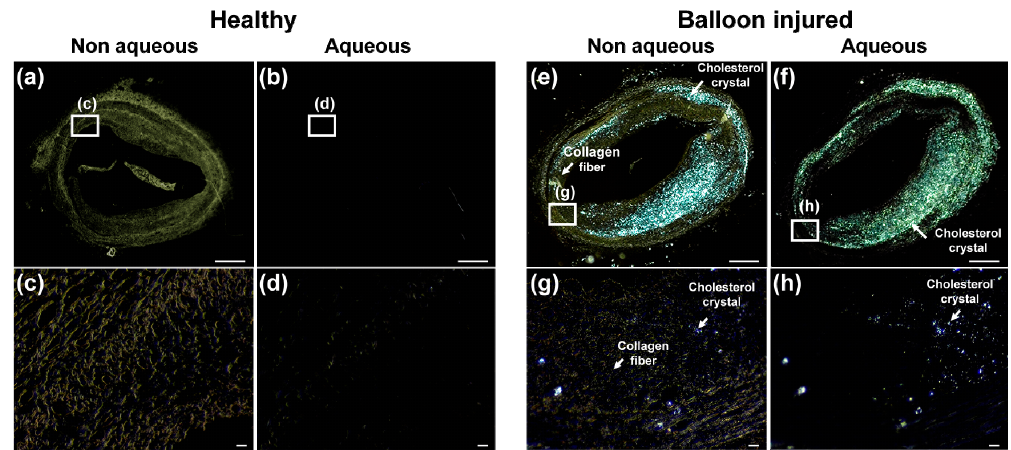
Figure 3. Polarization microscopy (PM) images of a sectioned rabbit artery sample. ( a – d ) are PM images of a healthy site of the artery and ( e – h ) is a balloon-injured site of the artery. Images were acquired under a non-aqueous ( a , f ) and an aqueous condition ( b , g ). ( c , d ) are highly magnified images of white-boxes in ( a , b ), respectively. ( g , h ) are highly magnified images of white-boxes in ( e , f ), respectively. Scale bars: ( a , b , e , f ) 500 μ m and ( c , d , g , h ) 20 μ m.